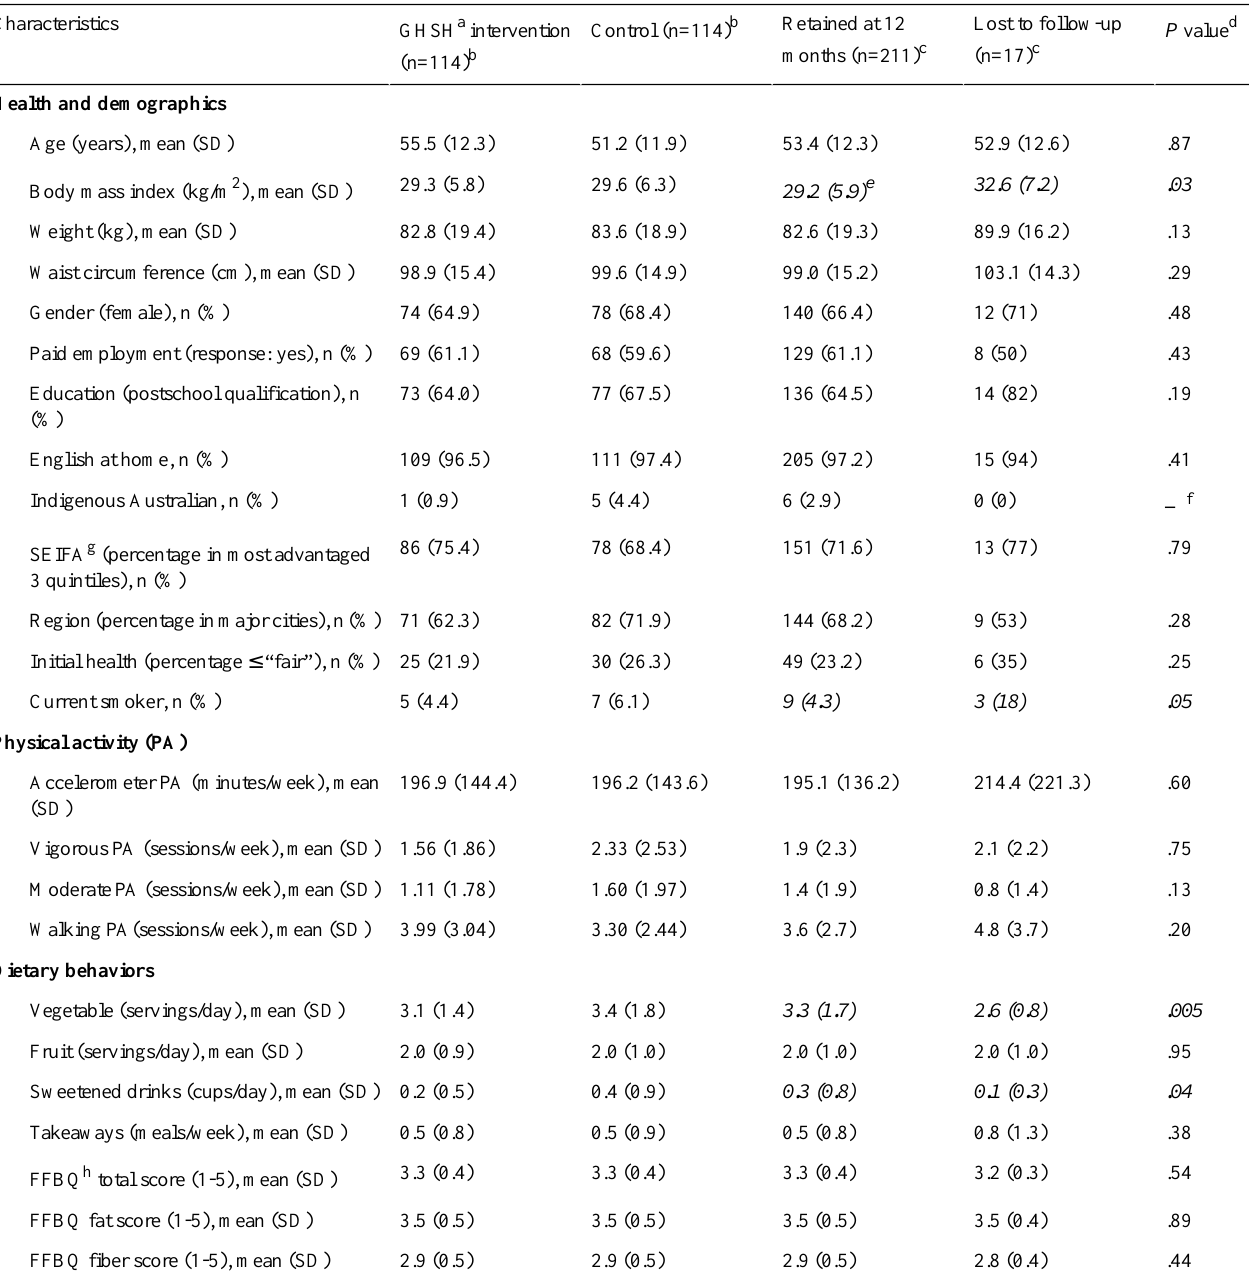
Table 1. Baseline characteristics of participants by study group and for those who remained in the study at 12 months and those who dropped out by 12